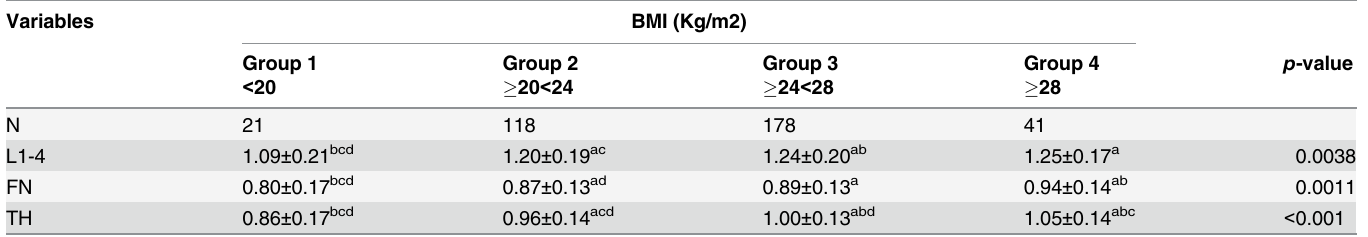
Table 2. The change of absolute value in BMD at different site by different BMI level.